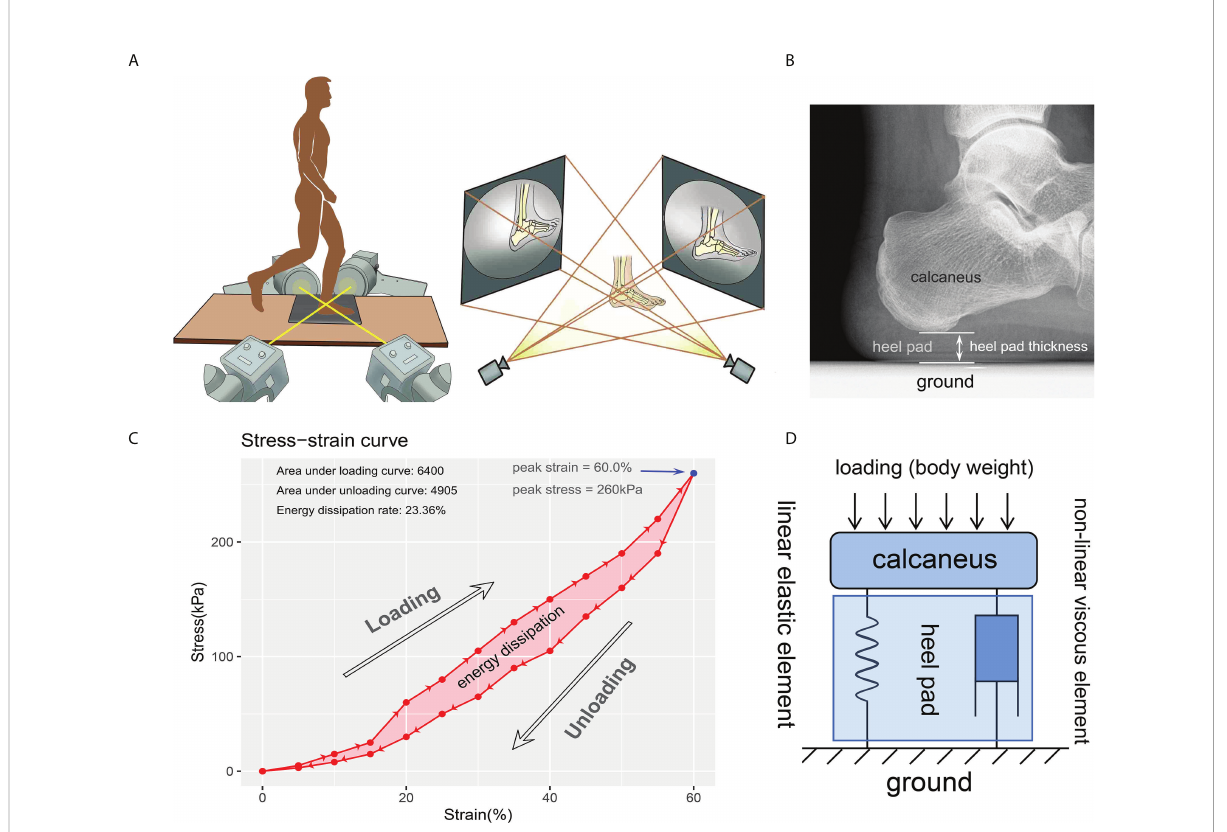
FIGURE 1 Diagrams for the experiment instrument and data process. (A) instrumentation including two orthogonally placed fl uoroscopes and dynamic foot-ground contact force plate embedded in the custom gait platform. Using this instrumentation, two 2-D images at each time were obtained for reconstructing the 3-D model and investigate the heel pad thickness. (B) thickness of the heel pad was de fi ned as the perpendicular distance between the ground and the base of the calcaneus. (C) a representative stress-strain curve depicting a cycle of loading and unloading. The most-right blue point indicates the peak stress (260kPa) and peak strain (60.0%). The energy dissipation was de fi ned as the area between the loading and unloading curves (the light red area), and the energy dissipation rate (23.36%) was de fi ned as the ratio between energy dissipation and area under loading curve. (D) modi fi ed Kelvin-Voigtviscoelastic model composed of parallelly connected linear elastic element and non-linear viscous element representing the viscoelastic characteristic of heel